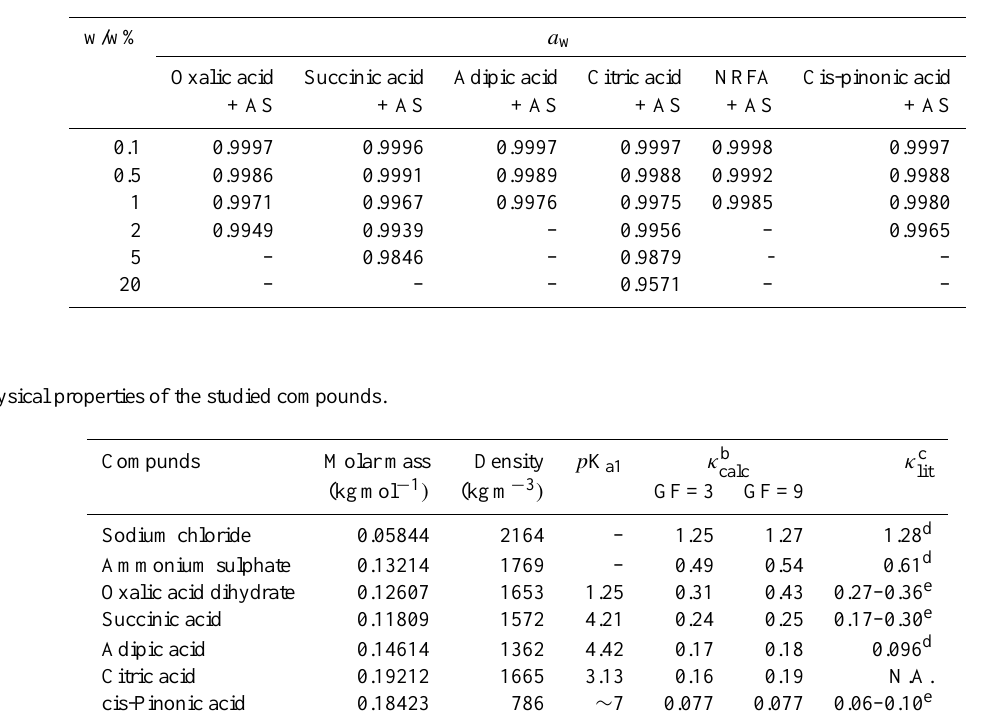
Table 4. Water activity ( a w ) as a function of weight percentage (w/w%) for the 50:50 mixtures between an organic acid and ammonium sulphate (abbreviations are explained in Table 1).